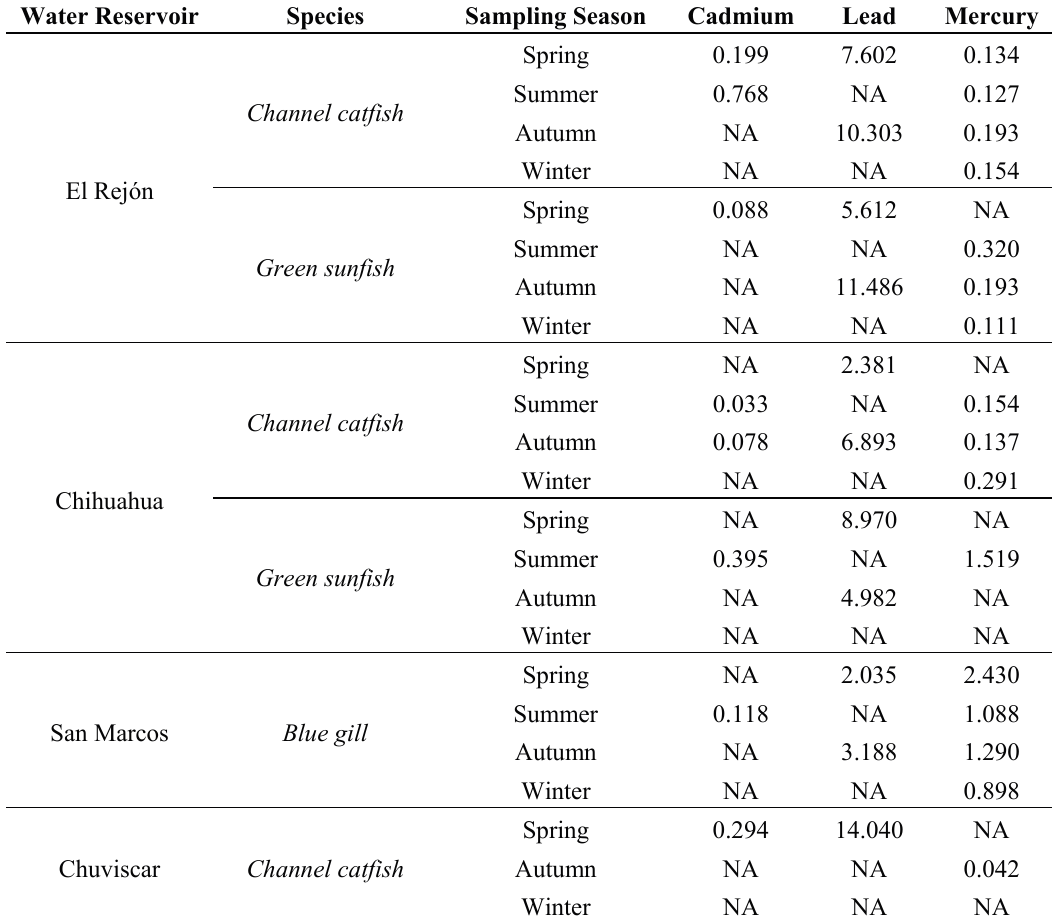
Table 3. Estimated weekly intake for cadmium, lead and mercury (µg/kg/bw/week) through fish consumption of local